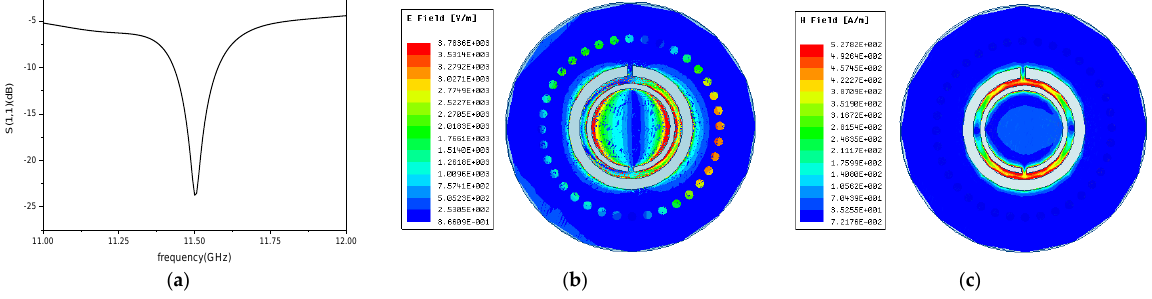
Figure 6. ( a ) Resonant frequency of the sensor, ( b ) electric field of the sensor, ( c ) magnetic field distribution of the sensor.